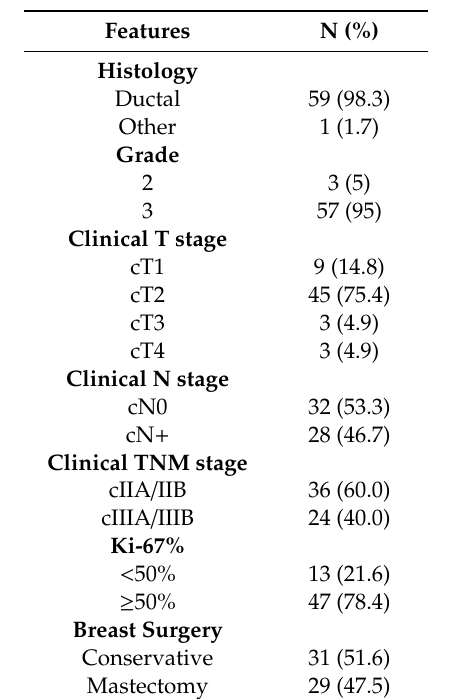
Table 1. Clinical and pathological features of the study